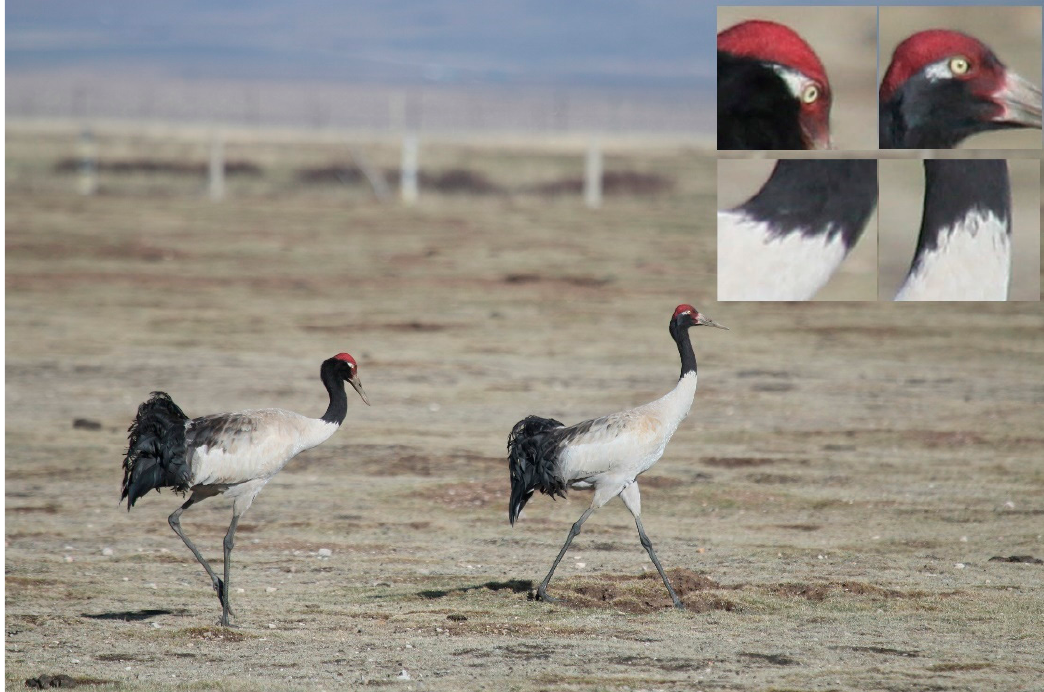
Figure 2. Irregular edge between black and white on necks and behind eyes of black-necked cranes (taken on 14 September